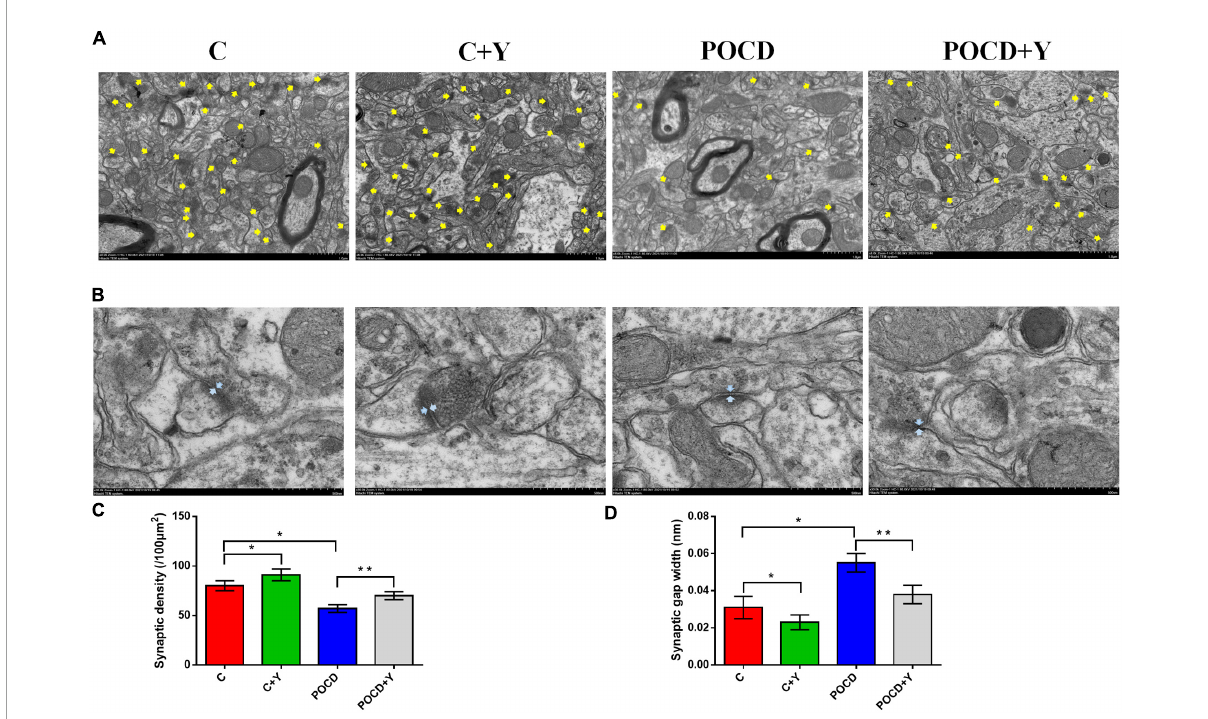
FIGURE6 Young plasma improved the ultrastructure of hippocampal synapses. (A) Representative images of hippocampal synapses under transmission electron microscope (TEM). The yellow arrows indicate synapse. Scale bar: 1 µ m. (B) Representative images of single synapse. The position between two gray arrows indicate synaptic gap width. Scale bar: 500 nm. (C) Quantitative statistics of synaptic density in different groups. (D) Quantitative analysis of synaptic gap width. Data are shown as mean ± SD. * P < 0.05 compared with group C, ** P < 0.05 compared with group POCD ( n = 8 per